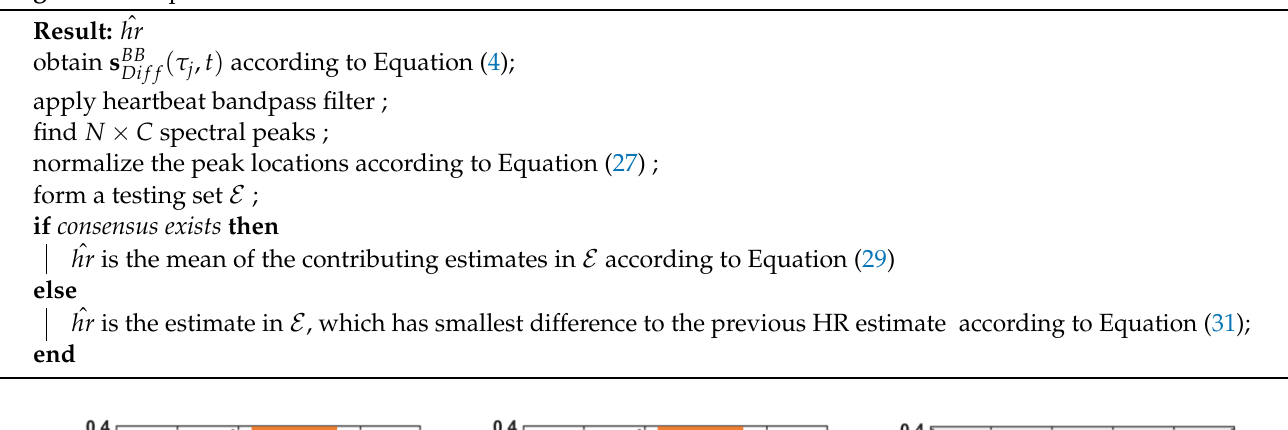
Algorithm 1: Spectral-Based Peak Selection for Heart-Rate Calculation